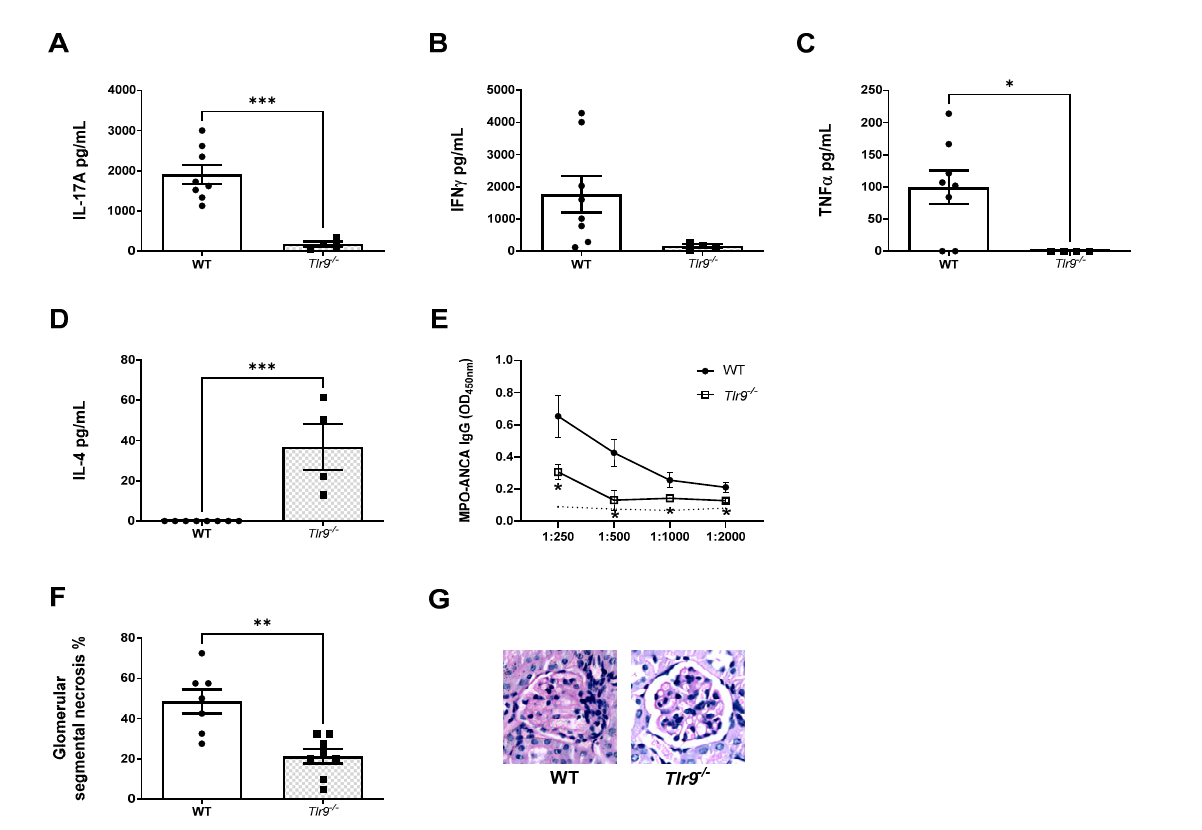
MPO pulsed Tlr9 − / − dendritic cells compared to WT dendritic cells (Figure 4E). Kidney injury was ameliorated in mice receiving TLR9 stimulated MPO pulsed Tlr9 − / − dendritic cells (Figure 4F,G).